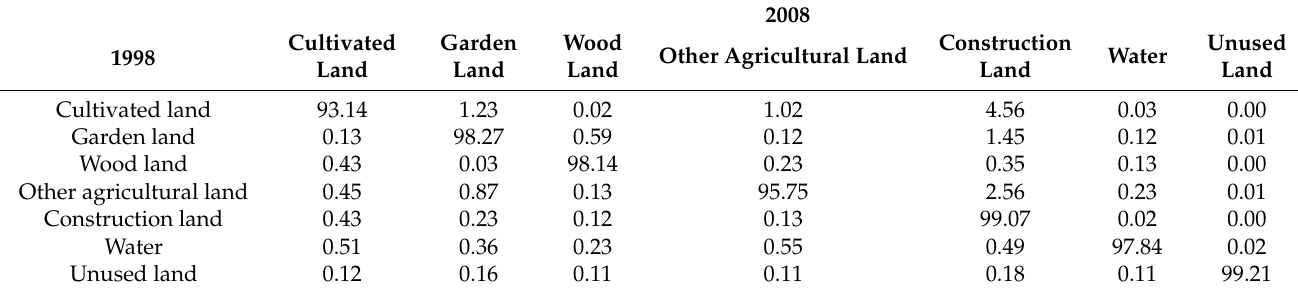
Table 1. Transformation matrix of landscape types in Suzhou City from 1998 to 2008 (%).